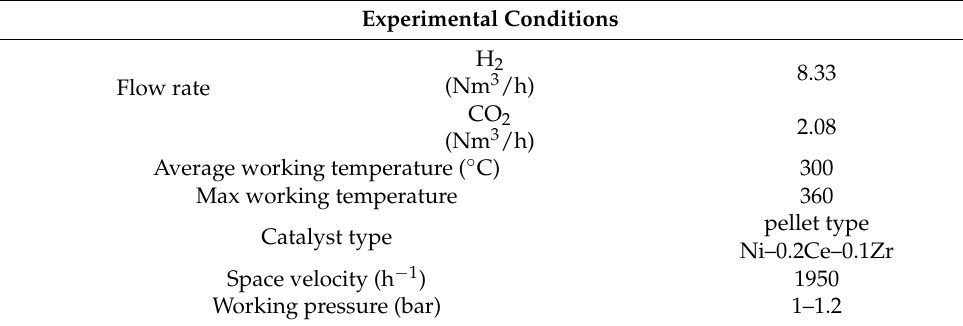
Table 3. Experimental